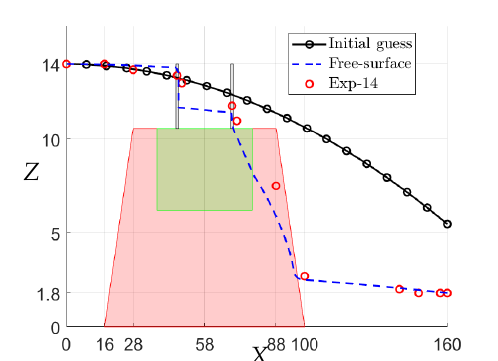
Figure 7. Free-surface of inflow at 12 cm.